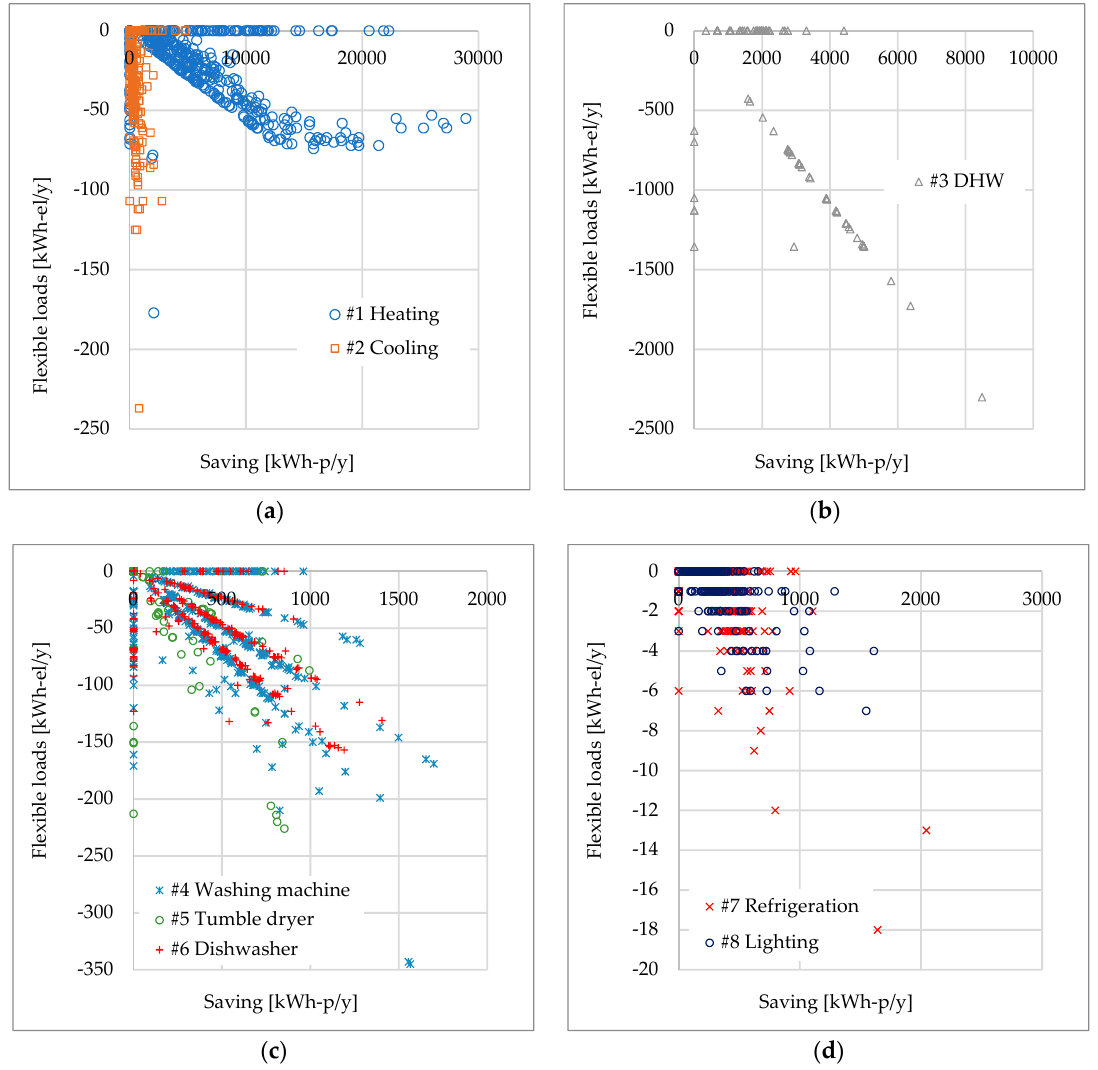
Figure 13. Changes in potential of flexibility vs. energy savings (as a function of primary energy) related to the evolutionary scenarios: ( a ) Heating & Cooling; ( b ) DHW; ( c ) Washing; ( d ) Refrigeration & Lighting.